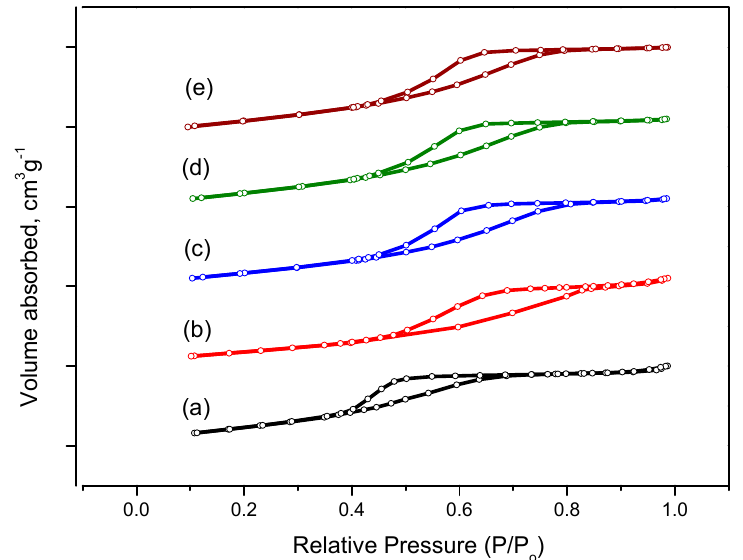
Figure 7. Nitrogen adsorption-desorption isotherm curves for fresh Al 2 O 3 samples prepared at various pH values: (a) Al-5; (b) Al-6; (c) Al-7; (d) Al-8 and (e) Al-9.